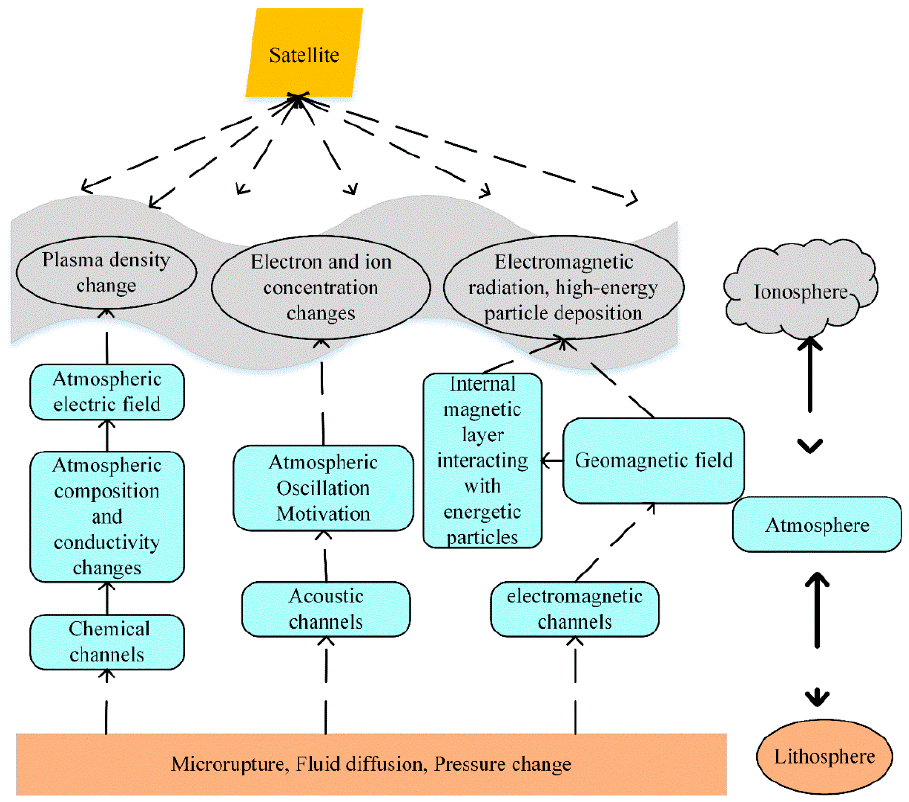
Figure 1. Lithosphere–atmosphere–ionosphere coupling mechanism.